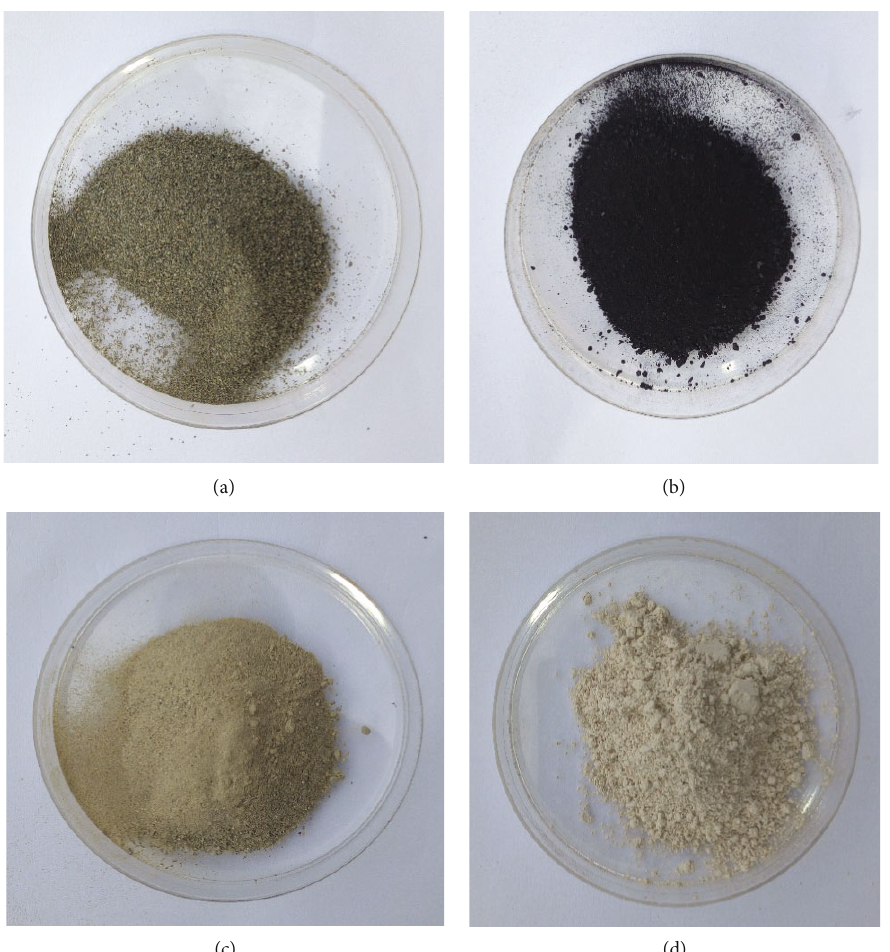
Figure 1: Dust samples used for the experimental study: (a) aggregate crusher dust; (b) coal dust; (c) fertilizer industry dust; (d) gypsum industry dust.